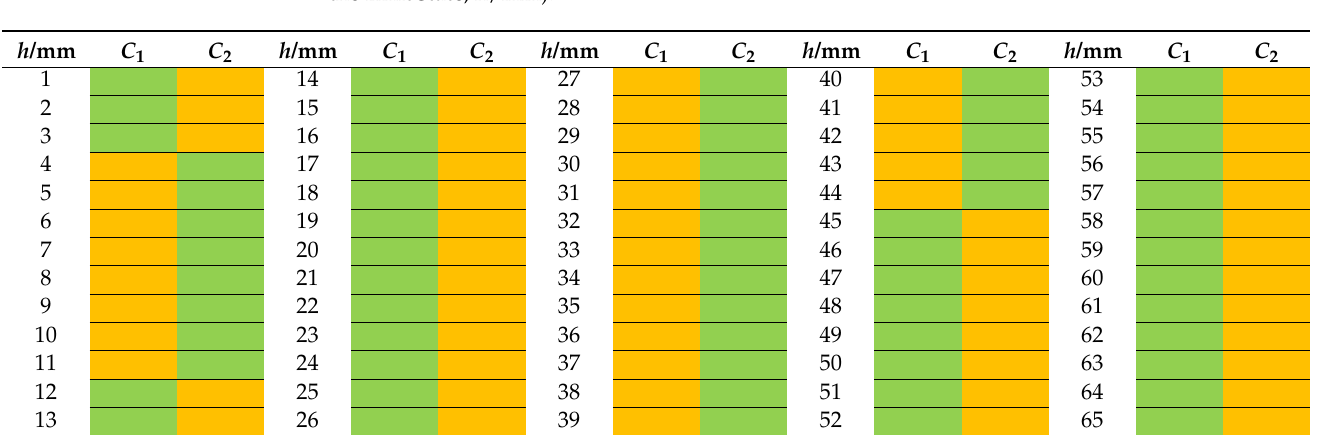
Table 2. Correspondence between stair height and segment unit (Orange: the standard state; Green: the limit state; h/mm).